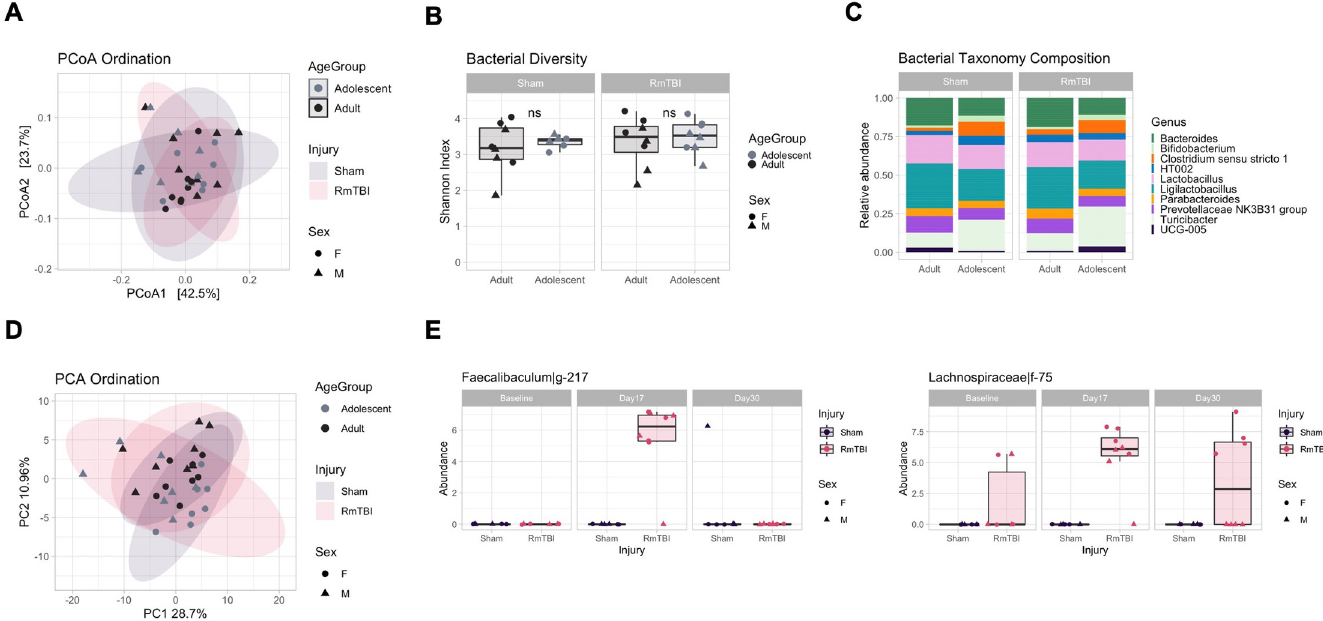
Fig 6. Comparison of placebo RmTBI adolescent and adult microbial and metabolomic profiles. (A) Principal coordinate analysis (PCoA) showing bacterial ordination by age group and injury at day 30. (B) Bacterial Shannon diversity boxplots, and (C) Taxonomy composition barplots, comparing injury and age groups at day 30. (D) Principal component analysis (PCA) showing metabolomic ordination by age group and injury at day 30. (E) Boxplots of differentially abundant ASVs between adolescent injury groups at day 17. Boxplots are indicative of median, interquartile range (IQR) (boxes) and 1.5x IQR (whiskers). n.s., not significant.